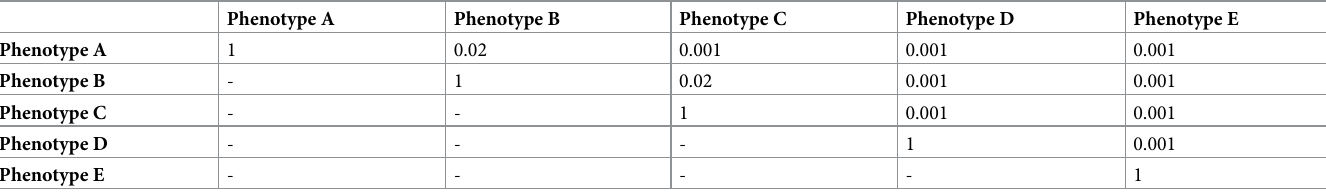
Fig 6. T-SNE and UMAP dimensional reduced visualisations for DeepGANnel and real data. For each of the channel phenotypes shown earlier (A to E), (i) T-SNE and (ii) UMAP projections are shown with “GAN” data on the left and “real” source data on the right. Sets of projections A to D correspond to those channel phenotypes shown in Fig 5, (A): “Channel phenotype A” canine articular chondrocyte. (B): “Channel phenotype C” WinEDR simulated. (C): “Channel phenotype B”, tracheal chondrocyte. (D): “Channel phenotype D” PVN data and (E) shows the same arrangement with the equine chondrocyte data shown in Figs 1 to 4. https://doi.org/10.1371/journal.pone.0267452.g006 available training data. There are two clear choices for such data; (i) real biological data that has been annotated in some way or (ii) synthetic datasets. Both approaches have biases and severe limitations. Real data cannot be perfectly labelled; the real ground truth is unknowable and so will only be an approximation. In practical terms, the longer the length of the real data, the greater the “ground truth” errors will be. As a result, new machine learning methods will learn the errors of the existing technology. Furthermore, only simple datasets can be annotated and so this sets an upper limit on the complexity of the datasets that could be analysed by Table 2. Statistical separation of UMAP clusters between real